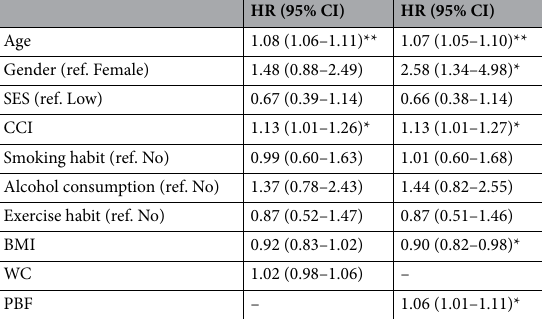
Table 3. Cox proportional hazard model analysis of the association between the BMI, WC, and PBF and all-cause mortality (N = 1,199). SES: socioeconomic status; CCI: Charlson comorbidity index; BMI: body mass index; WC: waist circumference, and PBF: percent body fat. * p < .05; ** p < .001.